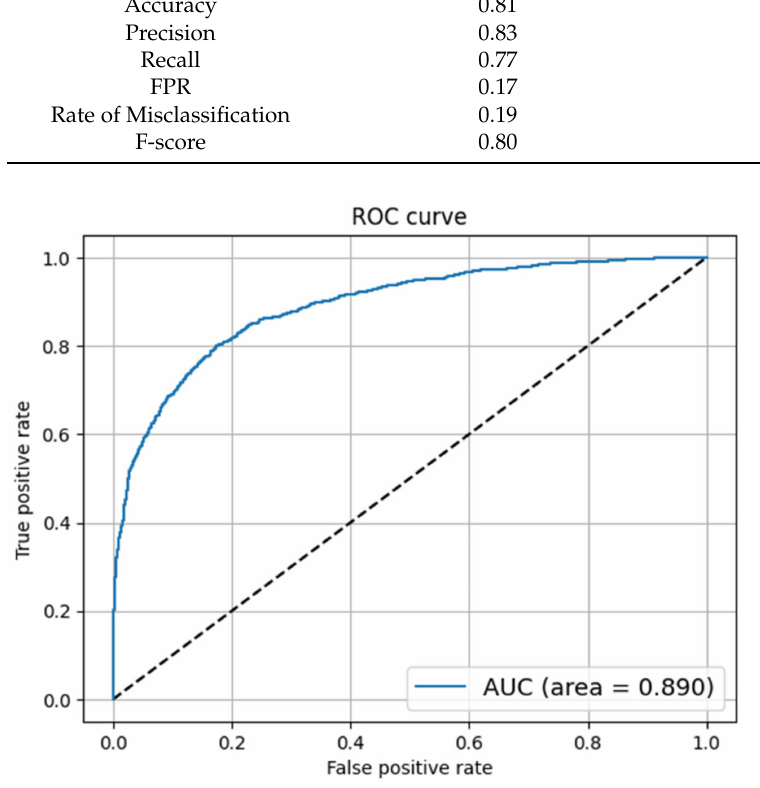
Figure 6. ROC curve of CNN on Constraint@AAAI 2021 dataset.